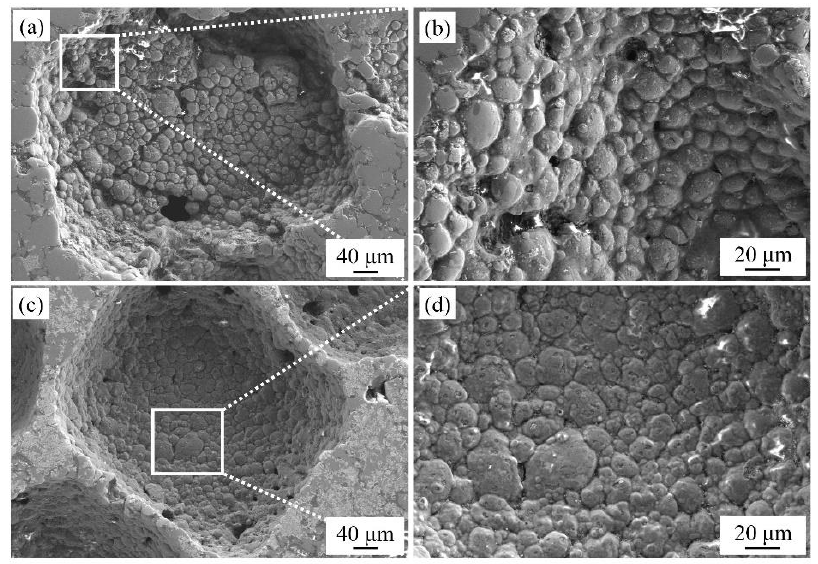
Figure 6. The SEM images of the pore walls of the porous composites with Zr content of ( a , b ) 5Zr and ( c , d ) 20Zr.